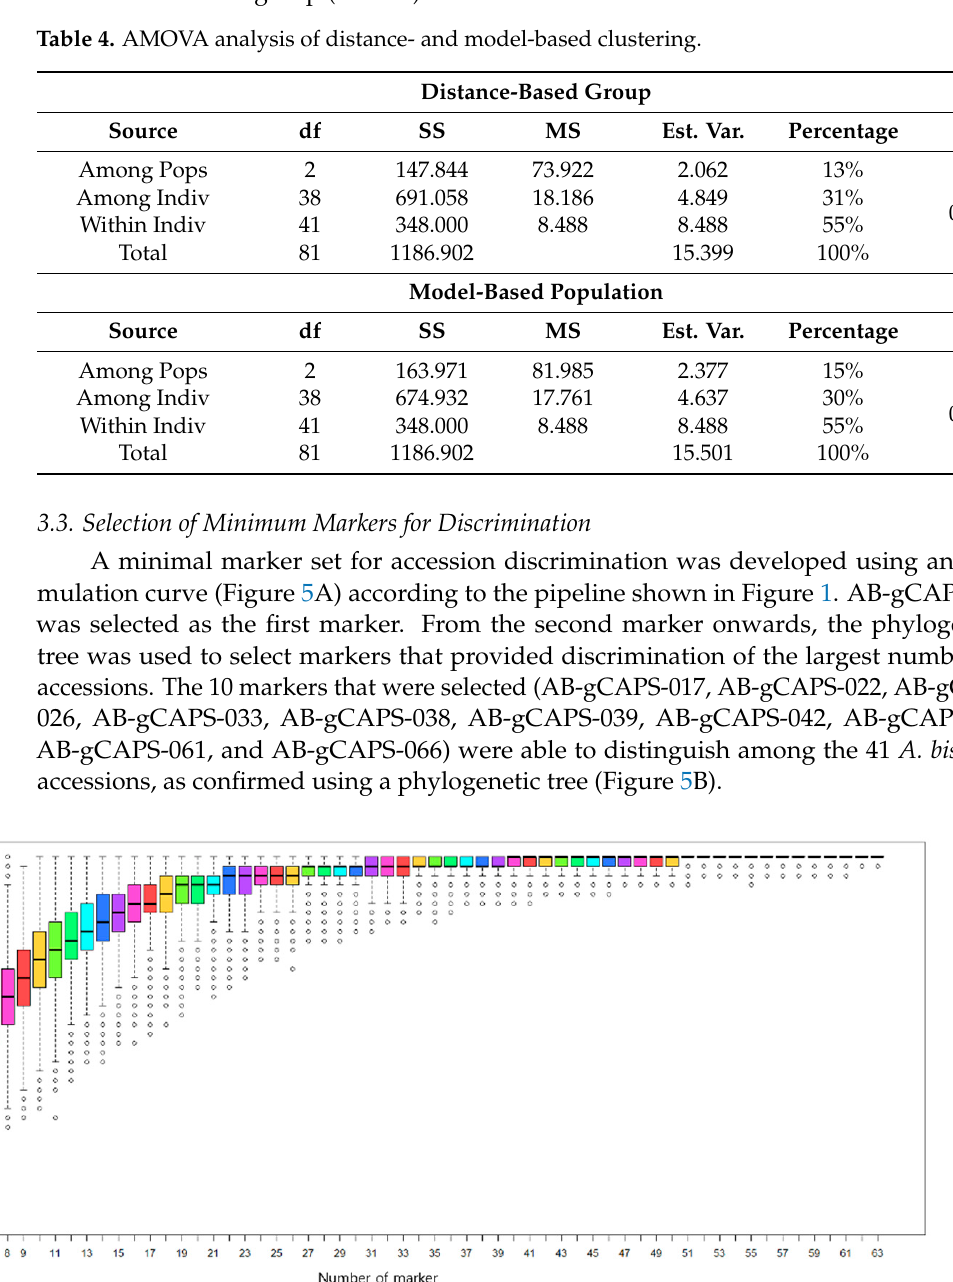
Table 4. AMOVA analysis of distance- and model-based clustering.